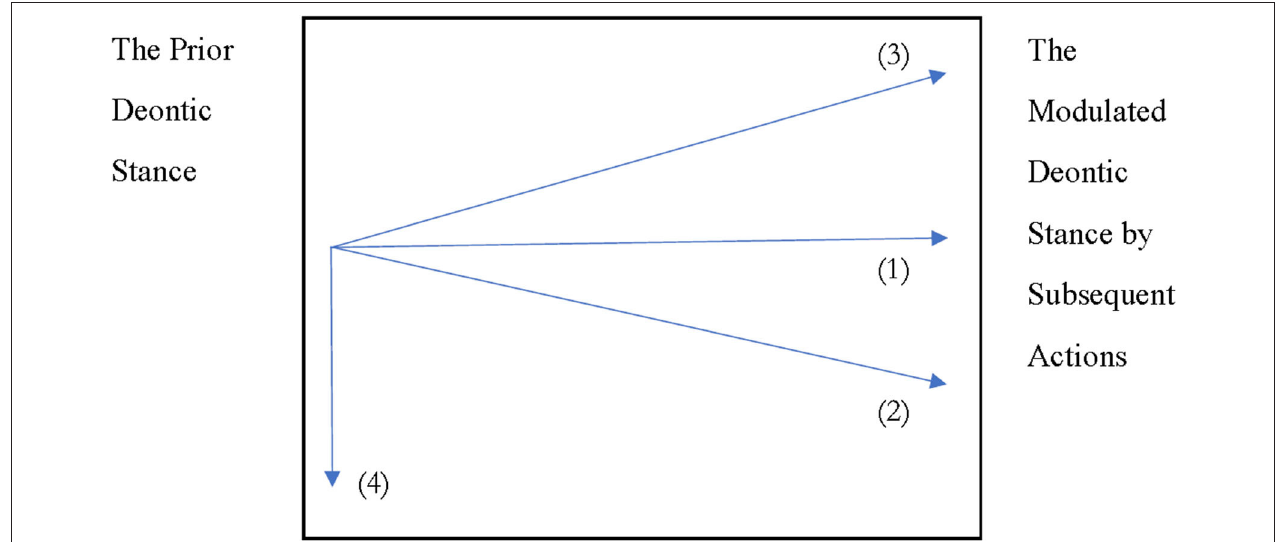
FIGURE 1 | The underflow of deontic stance in proposal sequences [Lines (1)–(4) stand for the four deontic trends modulated by subsequent actions proposers do after the absence of an immediate response].